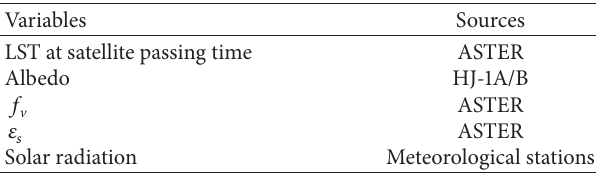
Table 1: General descriptions of the variables and